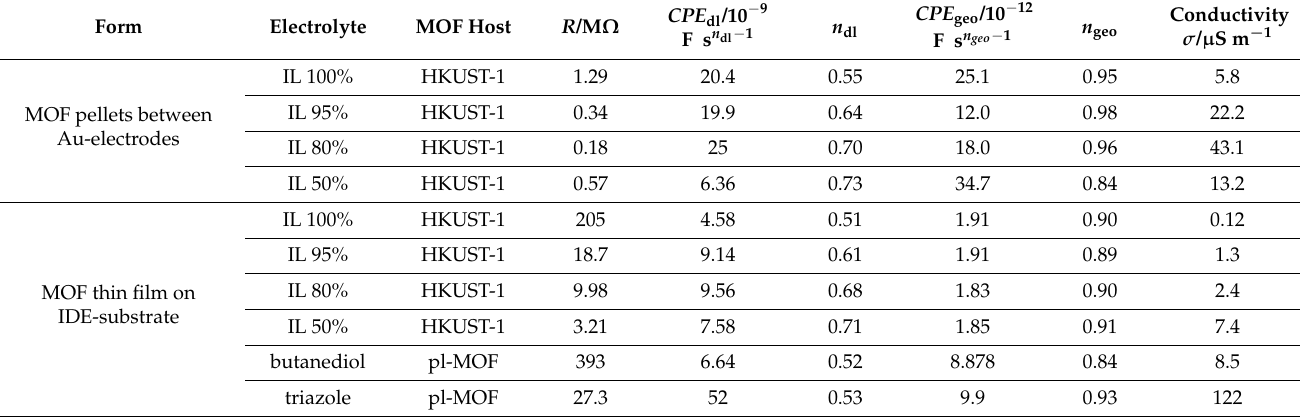
MOF thin film on